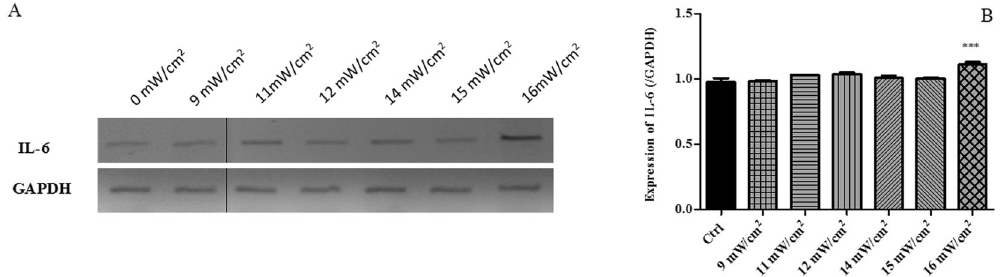
Figure 7. GAPDH and IL-6 mRNA levels analysed by RT-PCR ( A ) and Densitometric quantification ( B ). Columns and bars represent average and standard deviation value for three independent experiments. **** p ≤ 0.0001, *** p ≤ 0.001, ** p ≤ 0.01, * p ≤ 0.05; all results were analysed by ANOVA, and the significance was evaluated by the Tukey honestly significant difference (HSD) post hoc test. All graphs were elaborated with Graph Pad Prism 6.0. Full length gels are presented in Section 6, Figure S8 of ESI. The gels were run under the same experimental